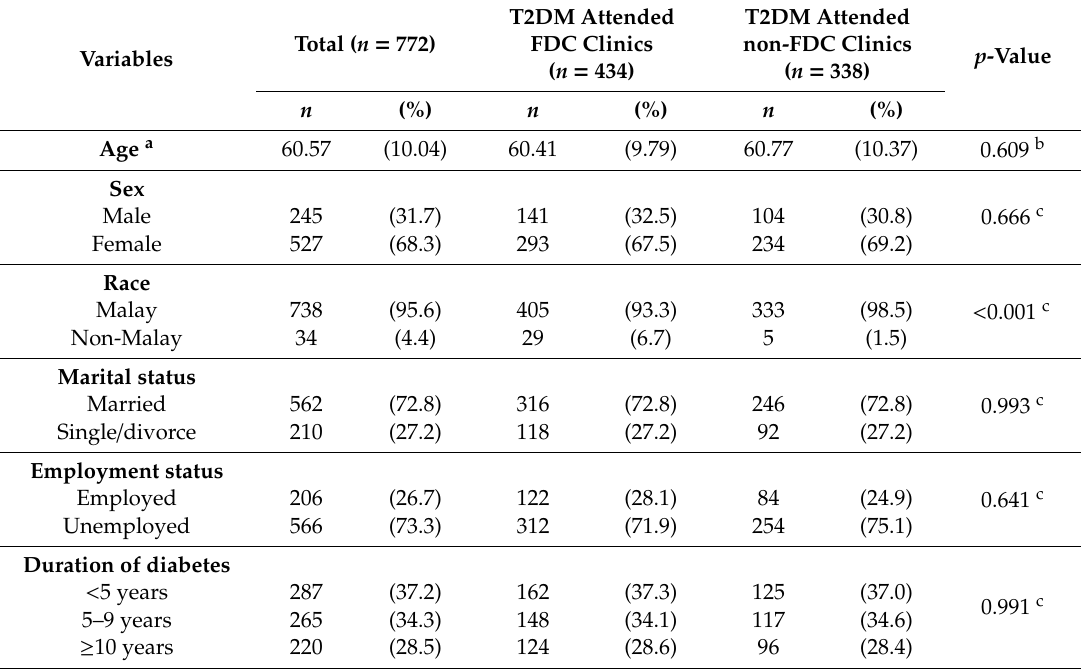
Table 1. Profile of T2DM patients attended primary health clinics in Kelantan ( n = 772).